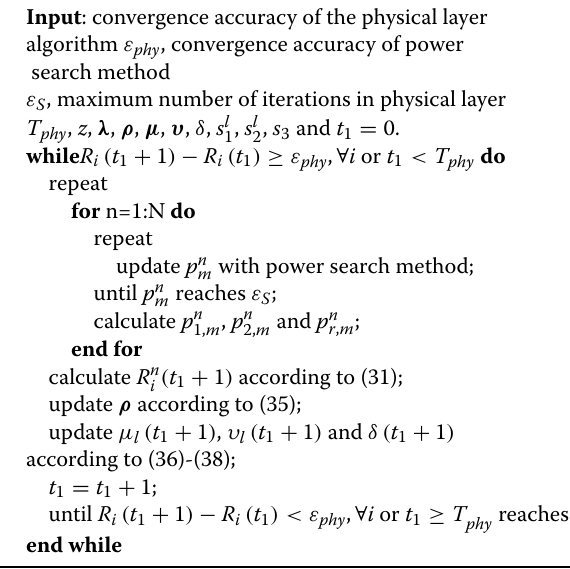
Algorithm 1: Physical layer